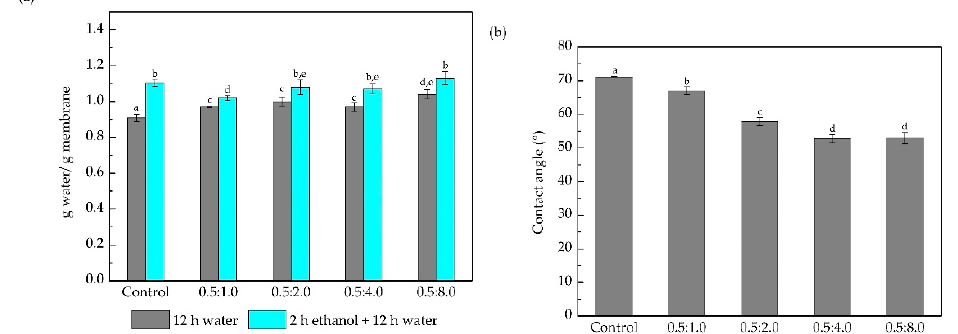
Figure 6. ( a ) Mass water uptake of control and membranes modified with different concentrations of DA and PEI after the immersion for 12 h in water (treatment 1), and the immersion for 2 h in ethanol and then 12 h in water (treatment 2). ( b ) Water contact angle of the control and membranes modified with different concentrations of DA and PEI. Bars with different letters show a statistical difference ( p < 0.05).